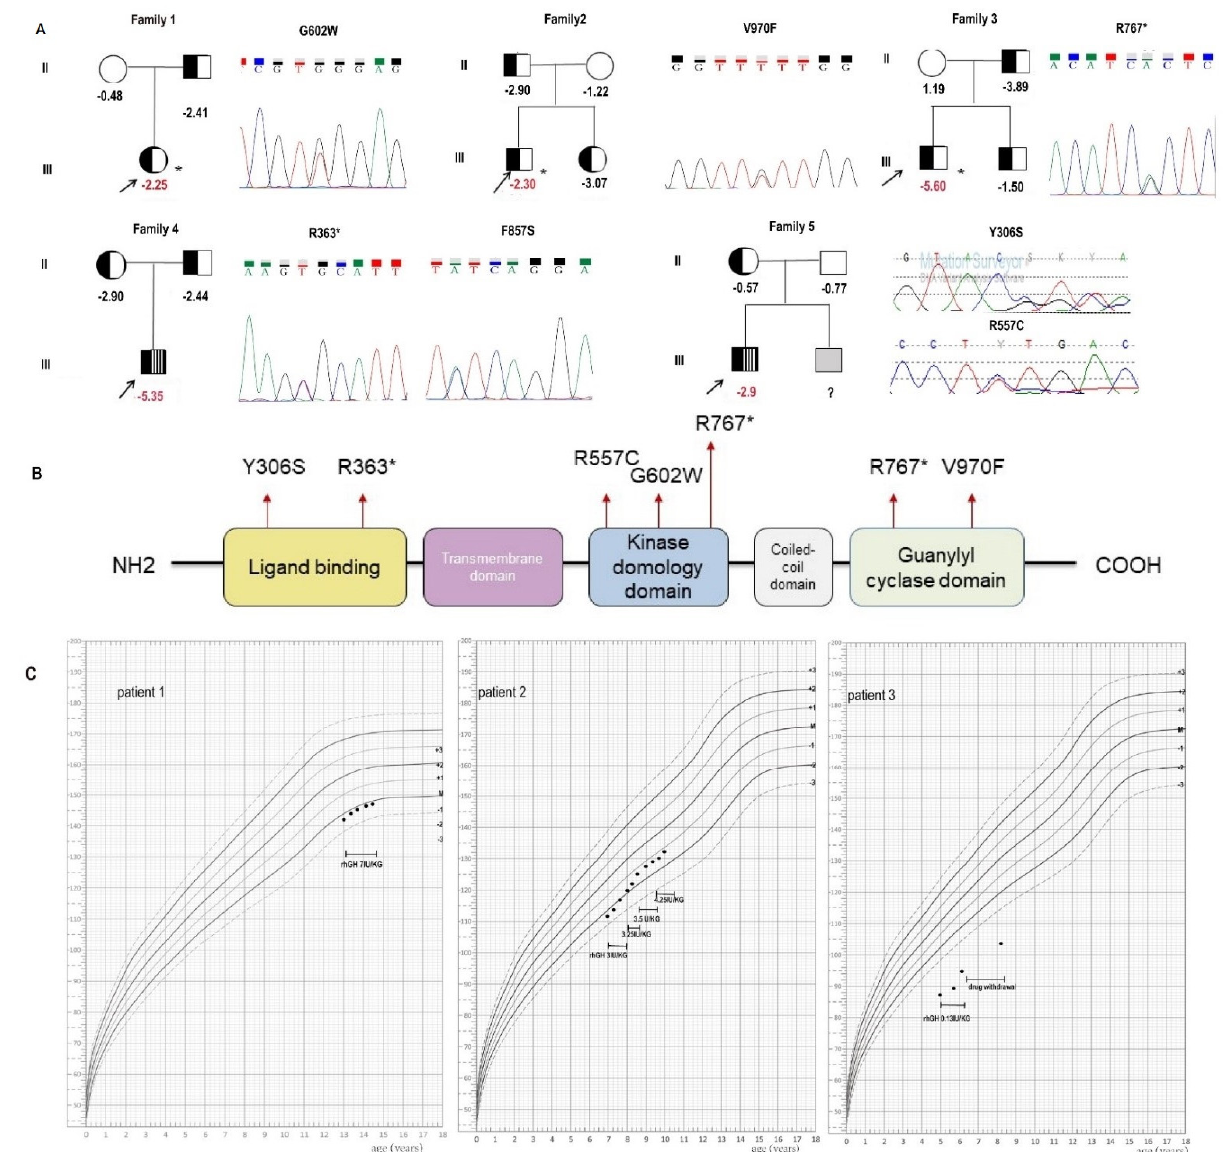
Figure 1. Clinical and genetic findings in five families with short stature. ( A ) Pedigrees of five Chinese families with short stature. ( B ) Diagram showing natriuretic peptide receptor 2 (NPR2) gene structure. The location of the present mutations is represented with a red point. ( C ) Height of the three patients after rhGH treatment. * patients with heterozygous mutations.